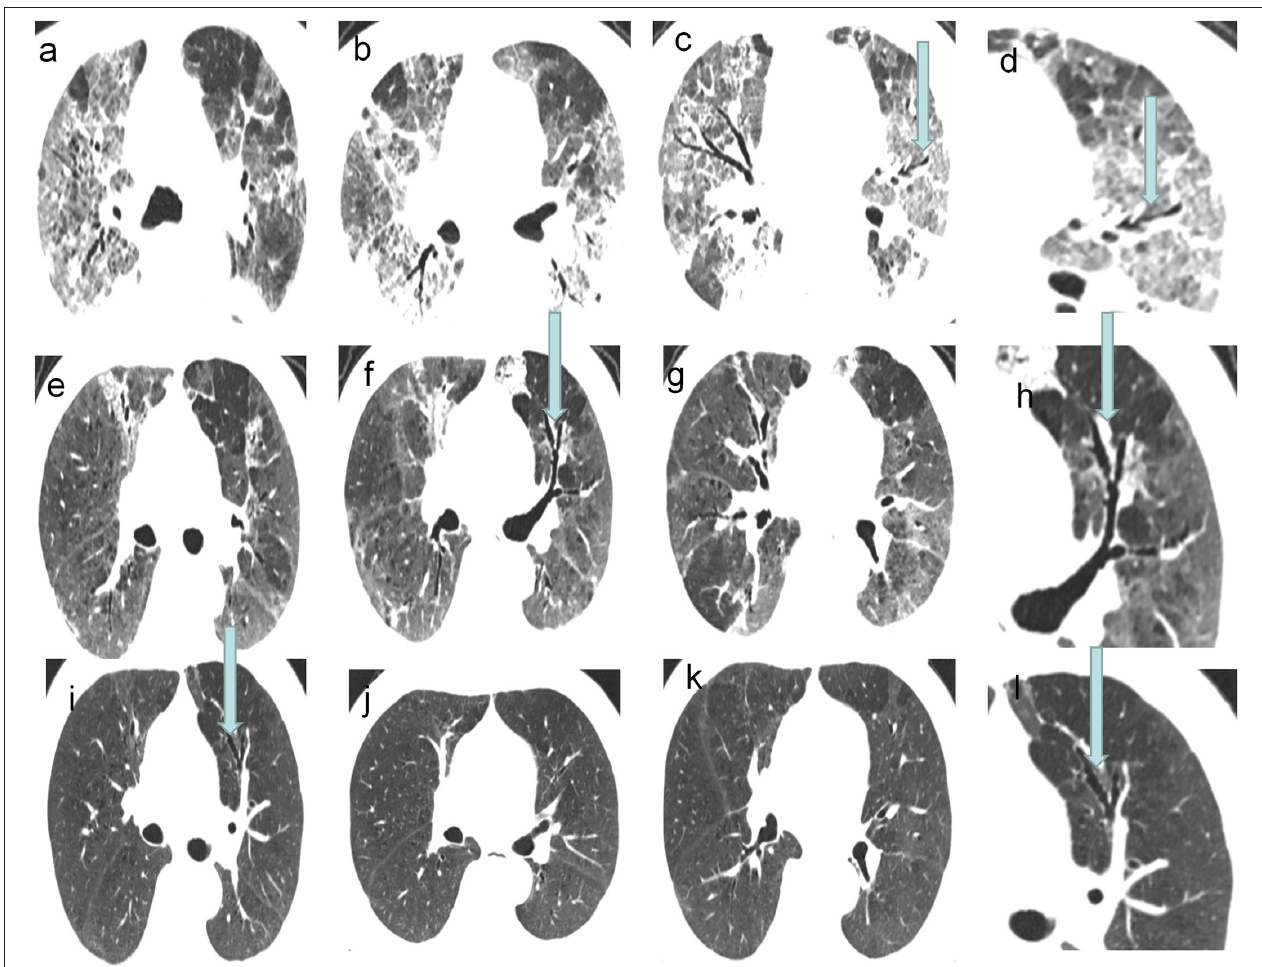
FIGURE 3 | A 73-year-old COVID-19 patients with ARDS: CT scans showed the traction bronchiectasis relived and disappeared incompletely. (a–d) CT images on 24th day of the symptom onset. (e–h) CT images on 38th day of the symptom onset. (i–l) Last follow-up CT images, on 145th day of the symptom onset, showed the traction bronchiectasis was still present in the left upper